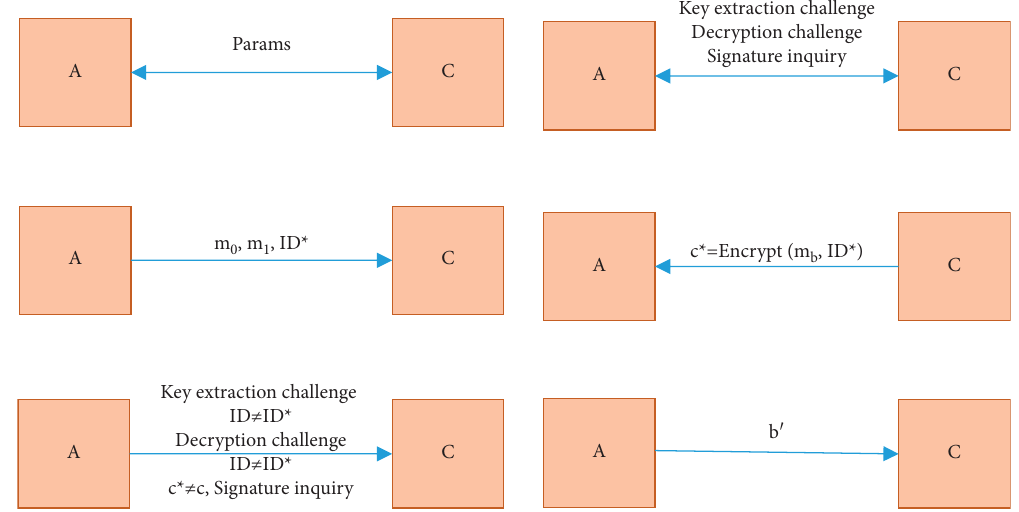
Figure 6: Schematic diagram of IBCES encryption system under